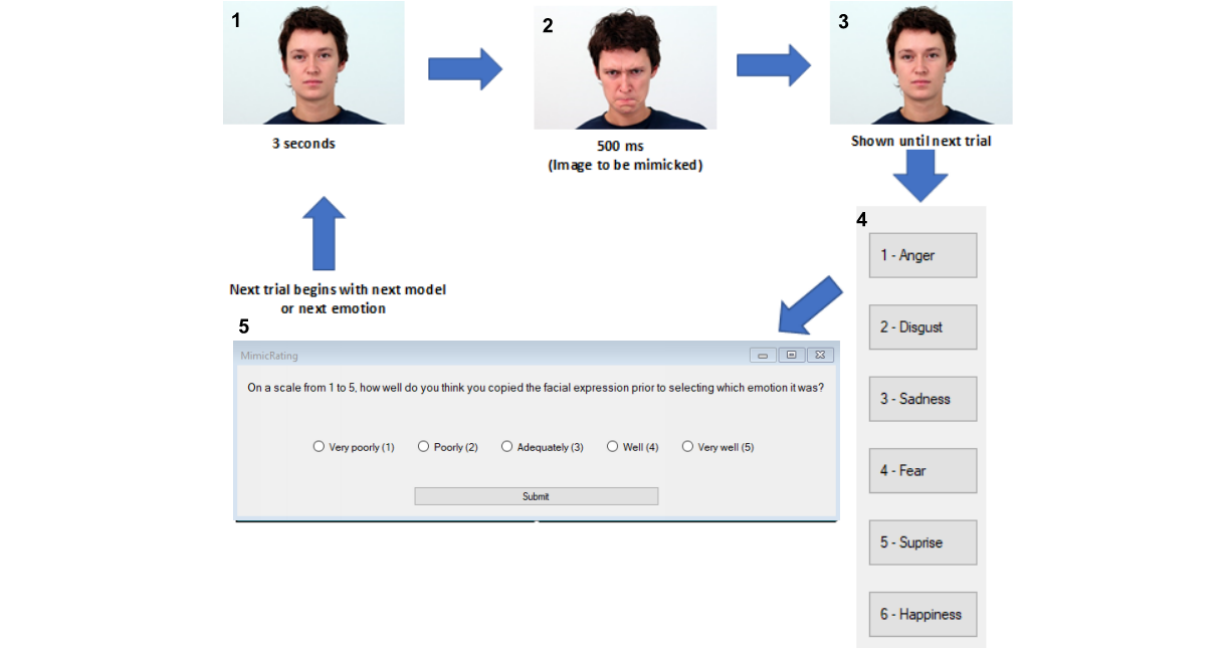
Figure 2. Task sequence and stimulus